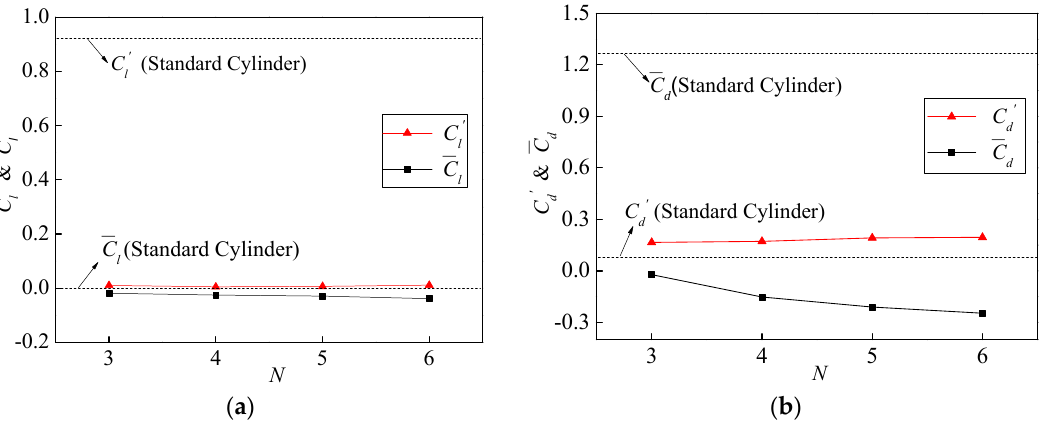
Figure 13. Characteristic values of lift and drag coefficient under different wave numbers. ( a ) C (cid:48) . ( b ) C (cid:48) & C d d